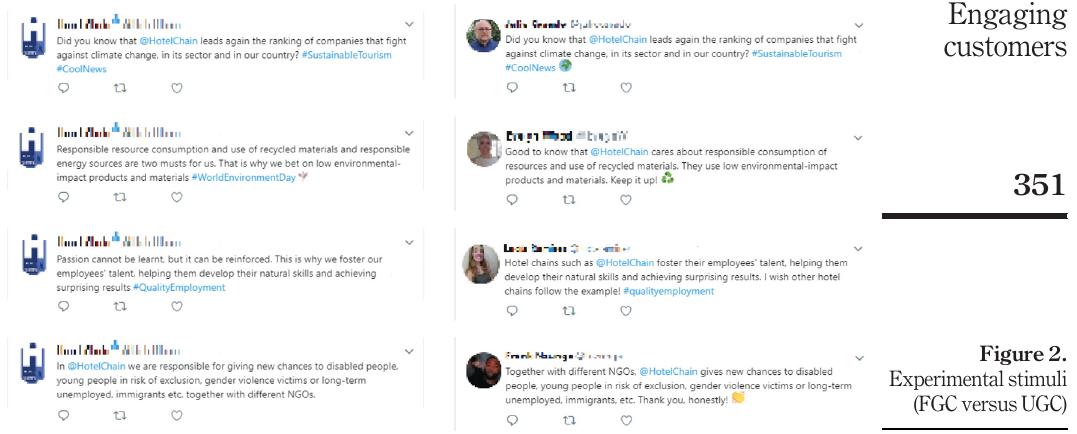
Figure 2. Experimental stimuli (FGC versus